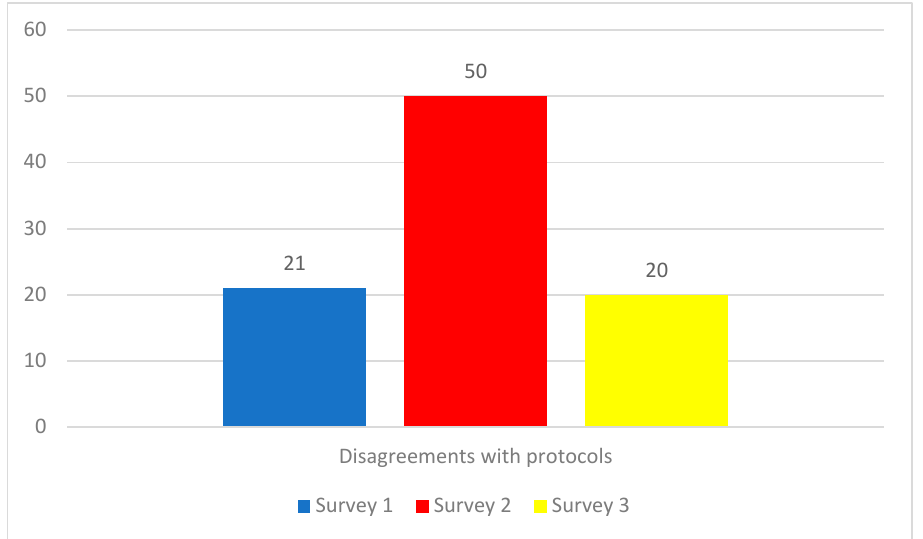
7 of 14 Figure 4. Number of responses corresponding to theme 2: Risks of COVID-19 infection and trans- mission. Since participants could select multiple themes, it is not possible to calculate percentages.